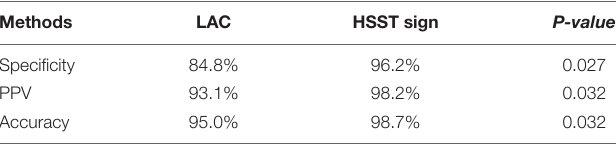
TABLE 4 | Test evaluation in